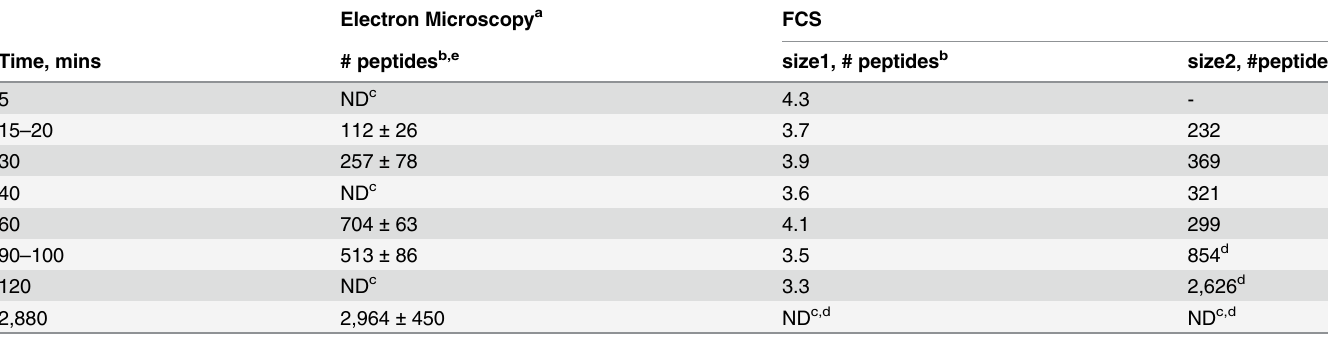
Table 2. Aggregation time course of HTT NT Q 37 P 10 C * K 2 by EM and